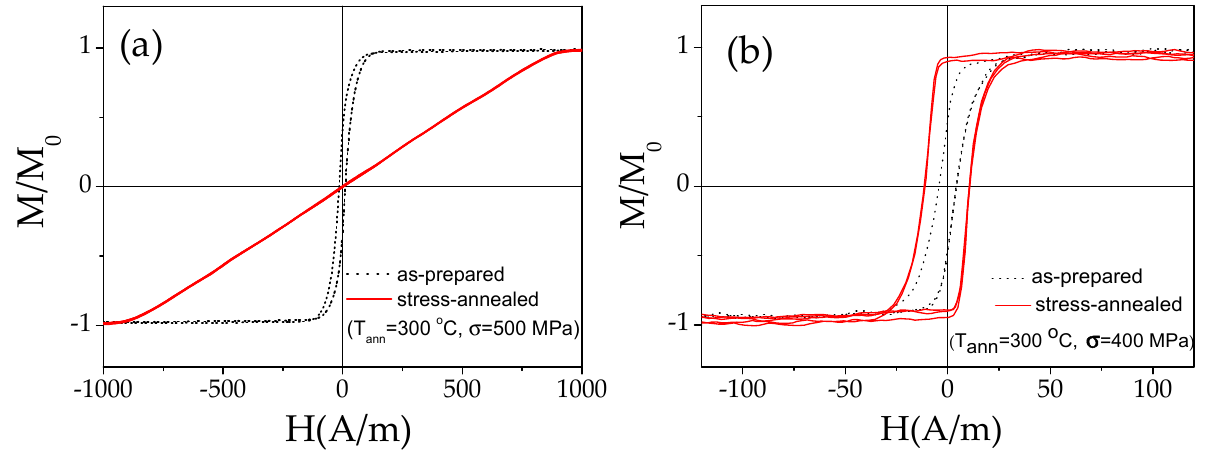
Figure 4. Effect of stress-annealing on hysteresis loops of sample 1 ( a ) and sample 2 ( b